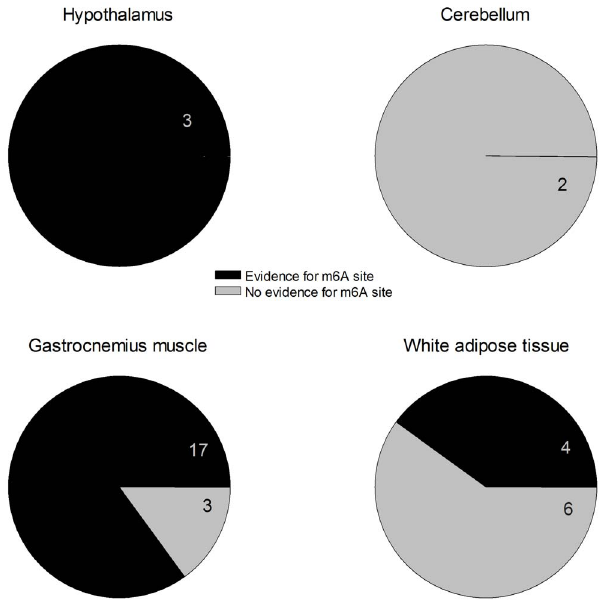
Figure 3. Effect of FTO overexpression on m6A levels in RNA. FTO mRNA expression in wild-type (black bar) and FTO-4 (white bar) MEFs as the fold change compared to wild-type (A). m6A levels measured as a percentage of adenosine levels for mRNA and total RNA by LC/MS in wild-type (black bar) and FTO-4 (white bar) MEFs (B). Significance was tested using Student’s t-tests to compare FTO-4 to WT data. **p , 0.01.